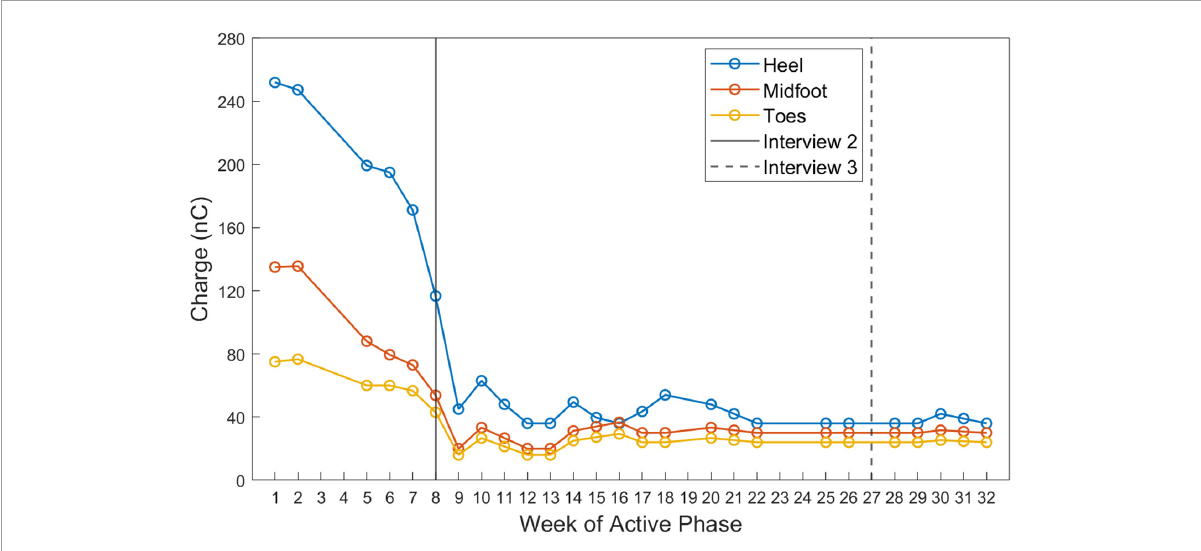
FIGURE4 Stimulation settings selected by the participant during the Active Phase of the study. The charge delivered during the cathodal phase of each stimulation pulse is displayed for each week of the Active Phase. Charge was calculated by multiplying the pulse width and pulse amplitude parameters selected by the participant on a given day. Color indicates the stimulation contact associated with the sensors in the heel (blue), midfoot (red), and toe (yellow) of the prosthesis. The timing of interviews 2 and 3 relative to the Active Phase are displayed as vertical